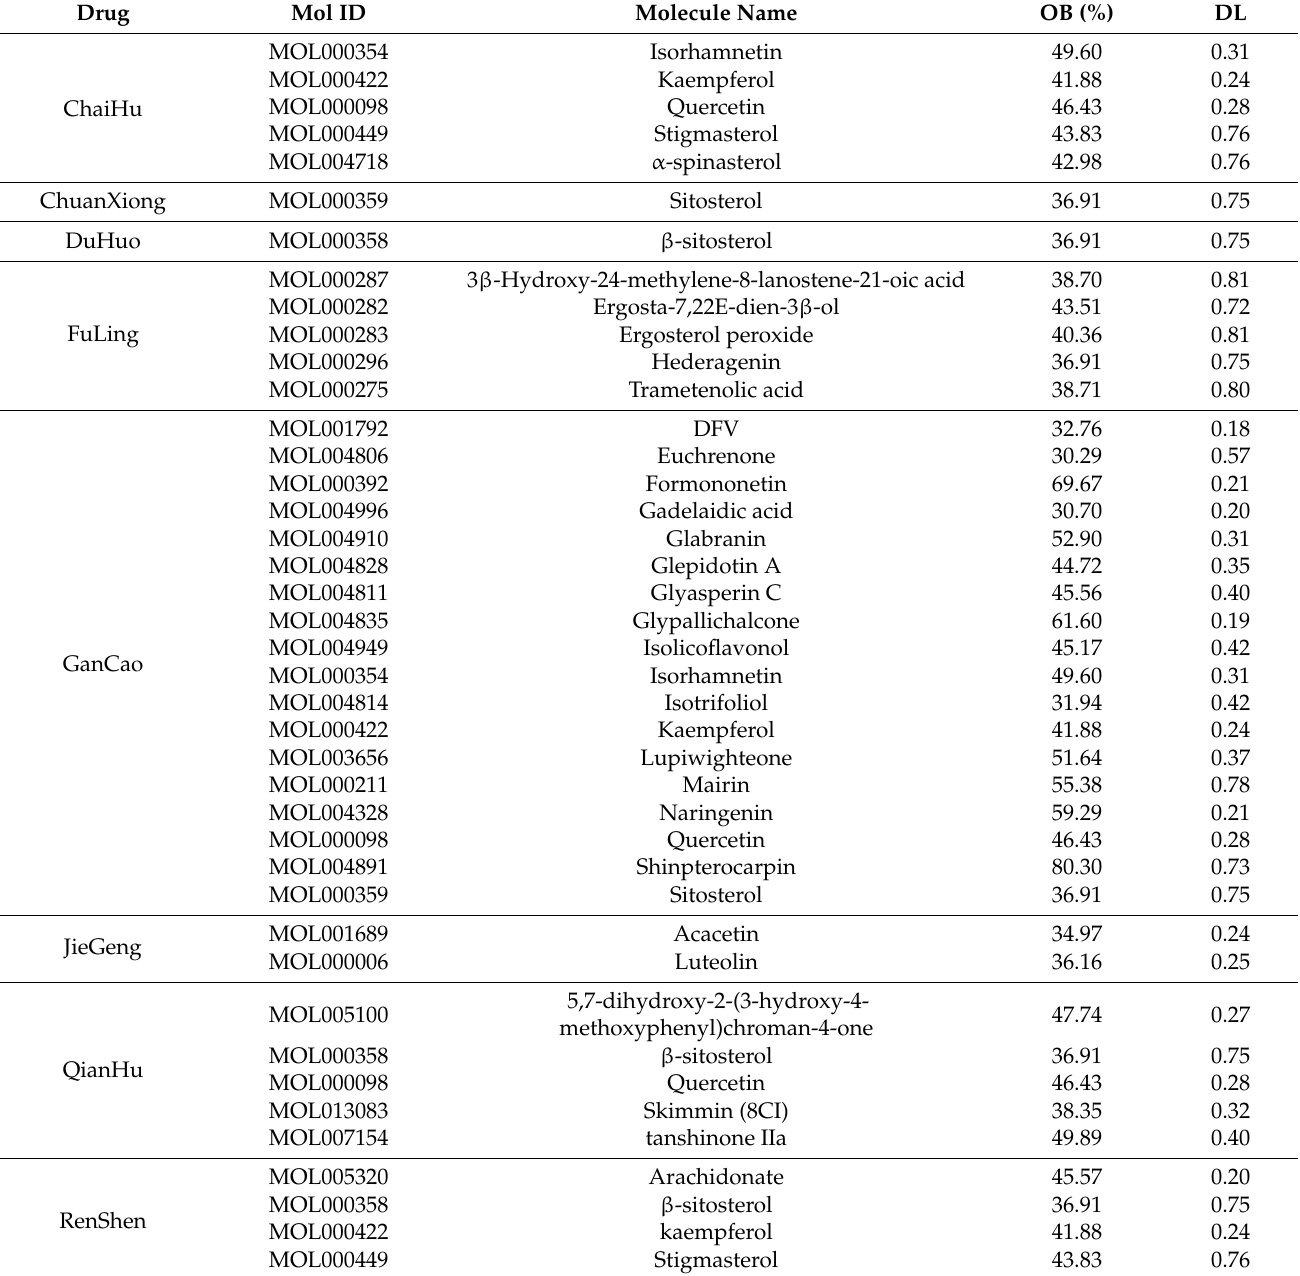
Table 1. The primary active ingredients of